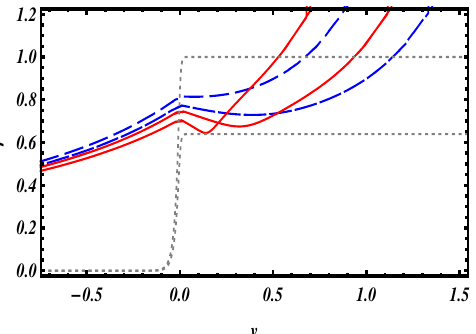
Figure 5 . Representatives of the two families of extremal surfaces for negative Gauss Bonnet coupling, (cid:21) GB = (cid:0) : 05. The family M S , red curves, contains surfaces that probe arbitrarily close to the singularity. The family M 0 , dashed curves, is very similar to the SAdS and (cid:21) GB > 0, they explore behind the horizon but do not reach the singularity.